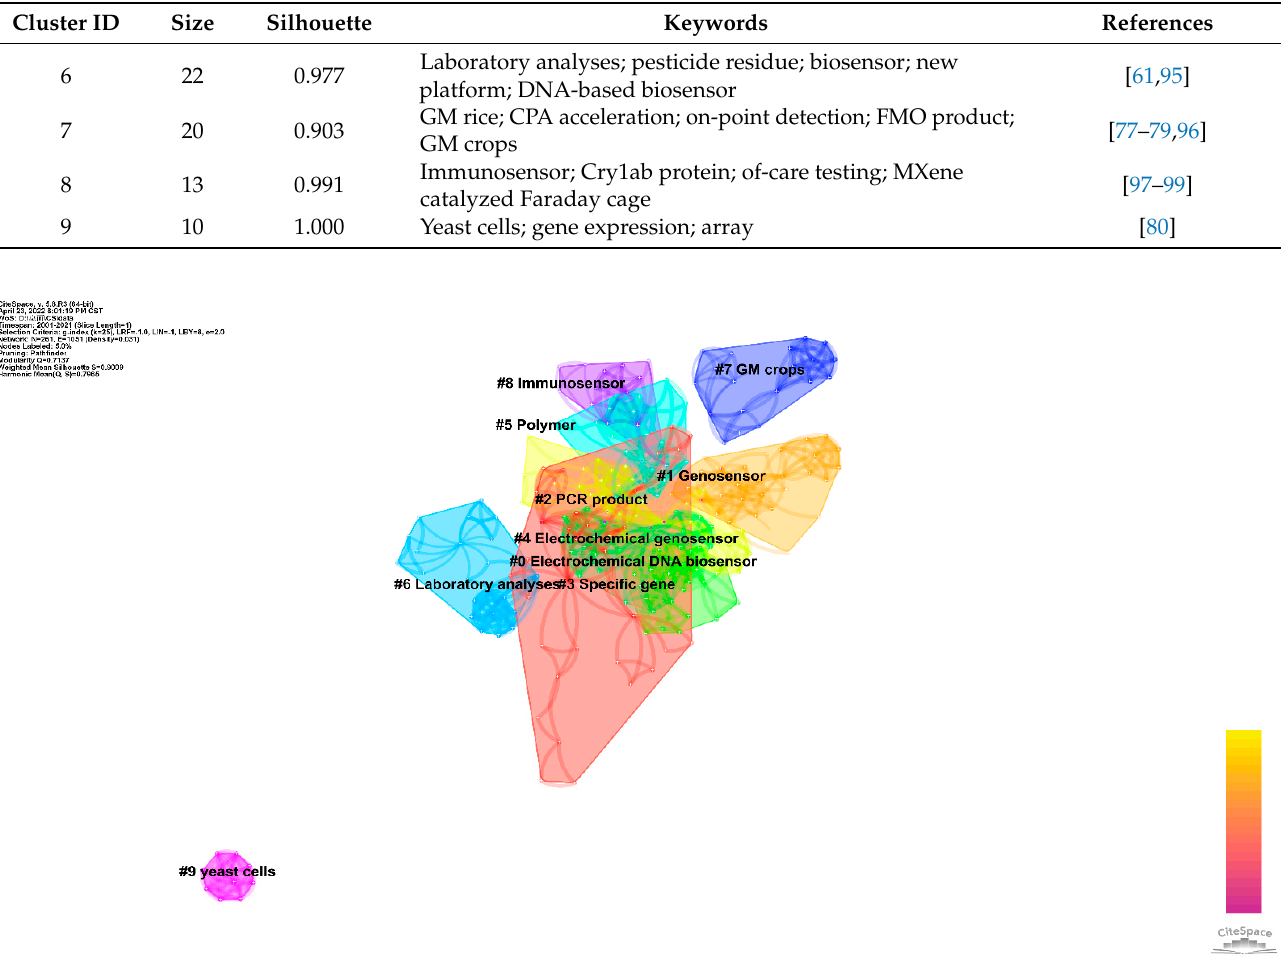
Figure 8. Grouping of keywords for electrochemical techniques for the detection and analysis of GM crops. Table 5. Knowledge clusters in the field of the detection and analysis of GM crops on keyword co- occurrences for each cluster.